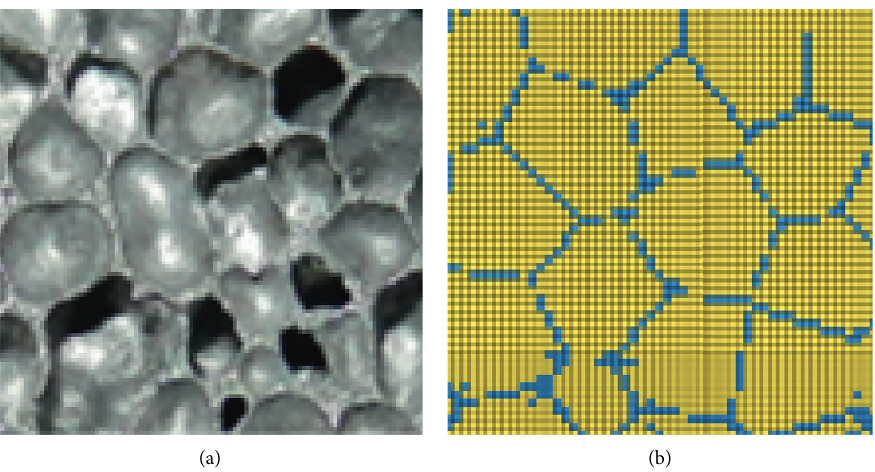
Figure 2: Comparison of different sections of the model with the real